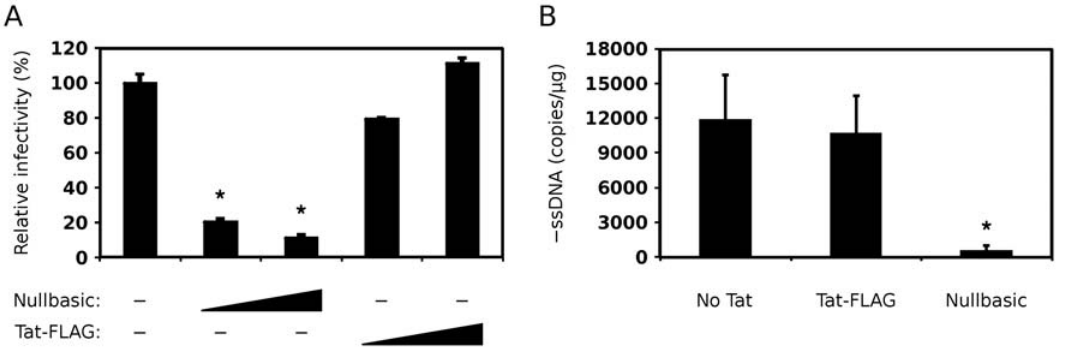
Figure 7. Nullbasic inhibits HIV-1 infectivity and endogenous reverse transcription. ( A ) The infectivity of HIV-1 produced by HEK293T cells expressing pGCH provirus co-transfected with empty vector (pcDNA3.1 + ) or co-expressing increasing amounts of Nullbasic or Tat-FLAG (at 1:2 and 1:4 molar ratios) were determined by the MAGI assay. The indicator cells were infected with virion samples equalized for reverse transcriptase activity before cell lysates were assayed for b -galactosidase production 48 h later. Columns represent the means and standard deviations of three independent experiments and are expressed as a percentage of the ‘‘No Tat’’ sample (column 1). Asterisks indicate significant differences ( p , 0.05) in infectivities compared to the ‘‘No Tat’’ sample. ( B ) Detergent-free endogenous reverse transcription assays were performed with the same virus samples as in A. The amount of negative-strand strong-stop DNA (–ssDNA) was quantitated by PCR, and normalized to the RT activity in each sample. The asterisk indicates a significant difference ( p , 0.05) in –ssDNA synthesis relative to the ‘‘No Tat’’ sample, and columns represent the means and standard deviations of duplicate assays in three independent experiments.